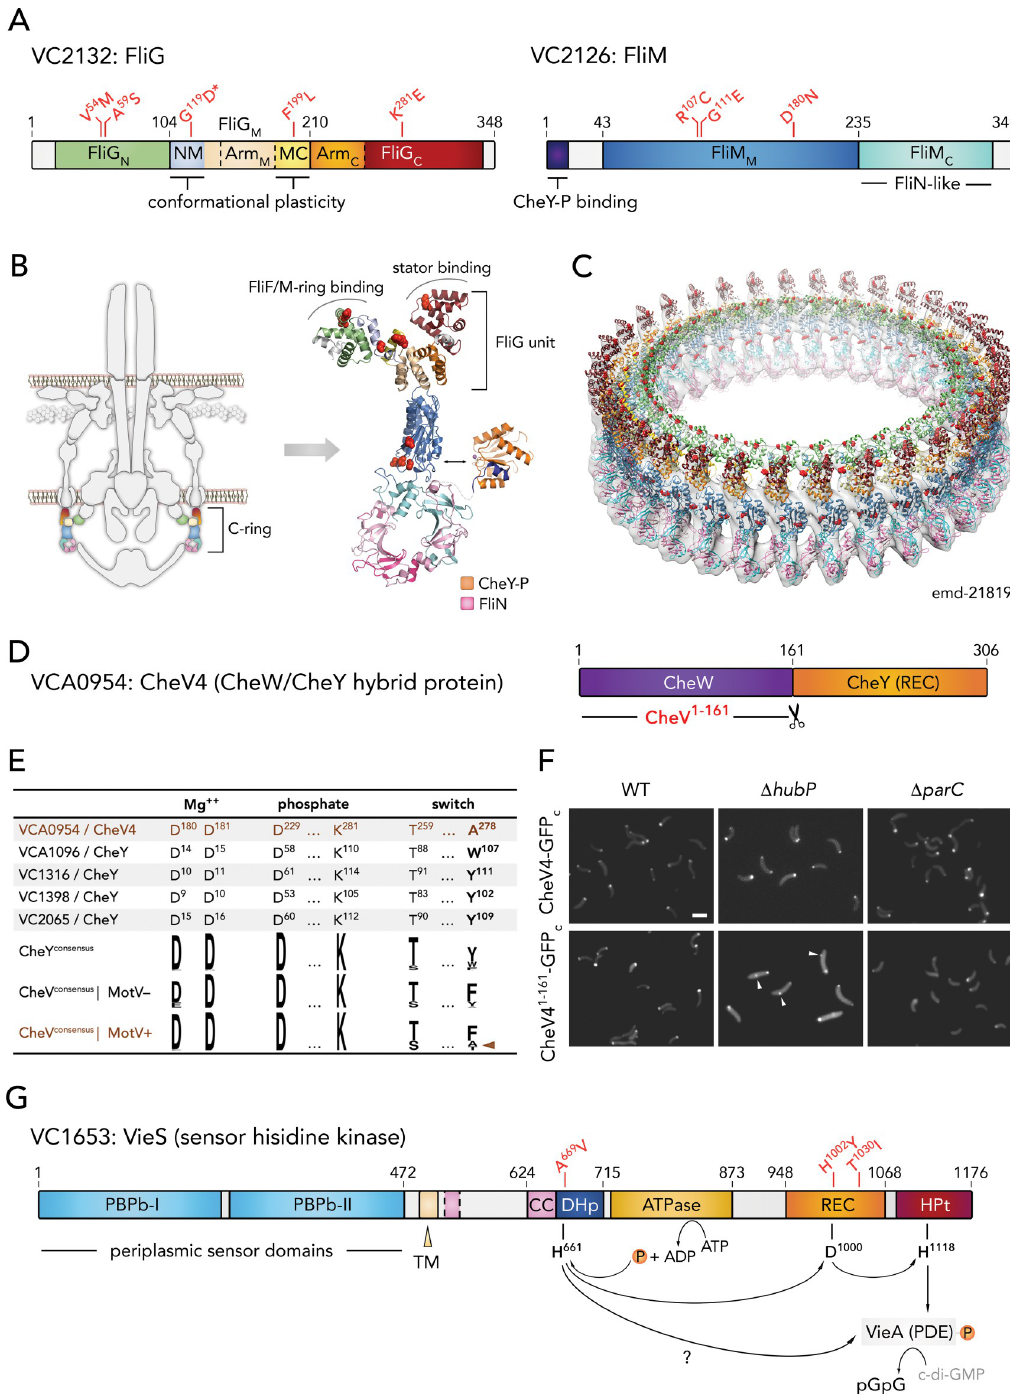
Fig 5. Motility regulators with identified Δ motV and/or Δ motW suppressor mutations. (A) Domain architecture of conserved C-ring component FliG (Left) and FliM (right). N , N-terminal domain; M , middle domain; C , C-terminal domain; NM, FliG N -FliG M domain linker; Arm, armadillo repeat-like motifs; MC, FliG M -FliG C domain linker; CheY-P, phosphorylated CheY. (B) Left, schematic of the V . cholerae flagellum with C-ring components in color. Right, cartoon representation of a homology model of a single FliG-FliM-FliN-CheY unit with color coding as in (A) and based on structural information from [45]. FliG and FliM amino acids mutated in the suppressor strains are highlighted as red spheres. The thumbnail representation of the flagellum is adapted with modifications from [45], under the license CC BY 4.0